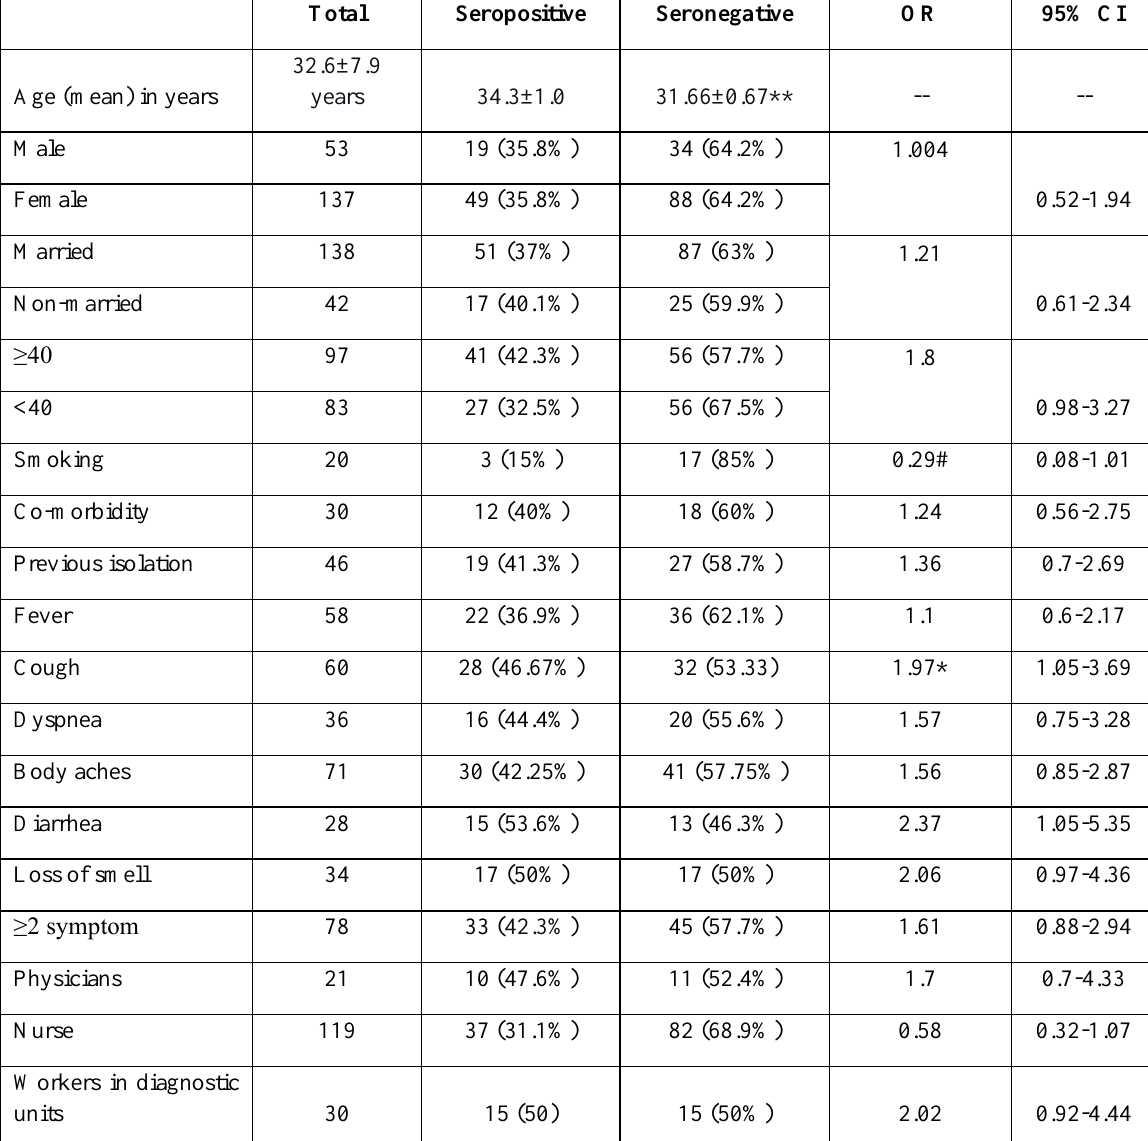
Table 1. Characteristics of the studied health care